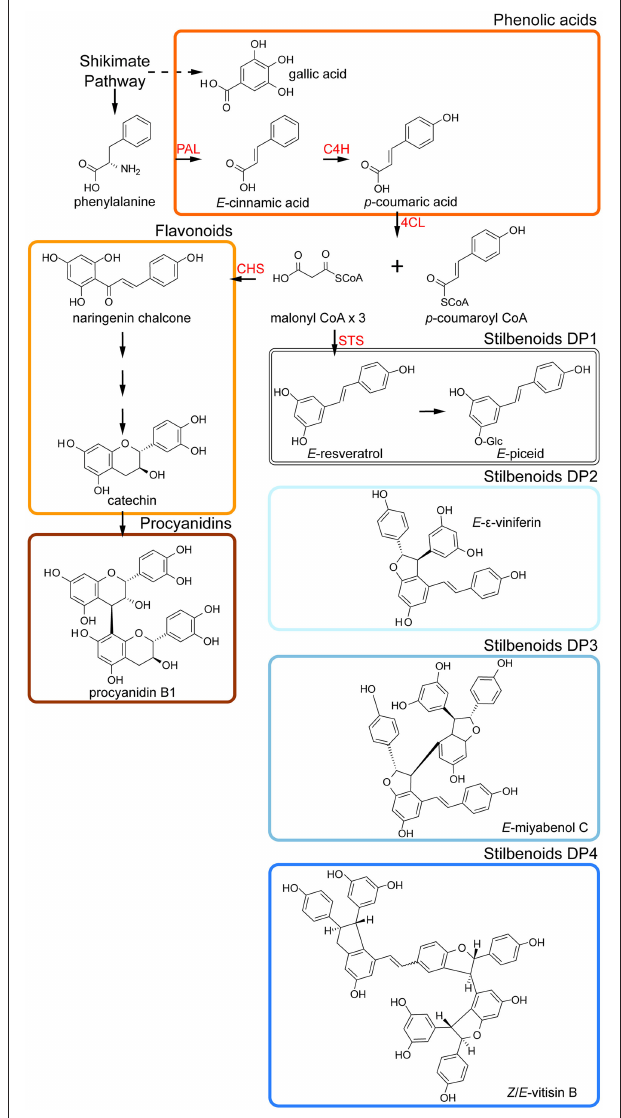
FIGURE 1 | Overview of polyphenol metabolism in grape stems. PAL, phenylalanine ammonia lyase; C4H, cinnamate 4-hydroxylase; C3H, 4-coumarate 3-hydroxylase; 4CL, coumaric acid CoA ligase; CHS, chalcone synthase; STS, stilbene